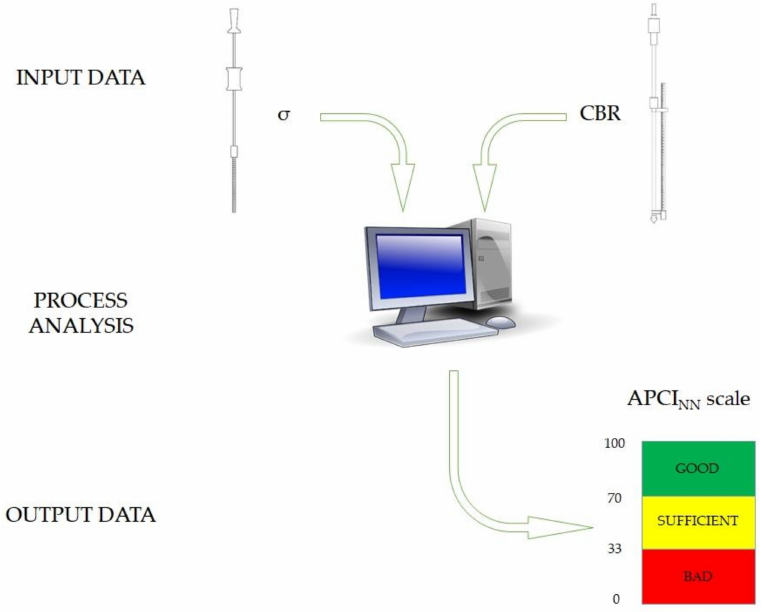
Figure 5. Procedure for assessing the technical condition of the natural airfield’s functional element pavements using the APCI